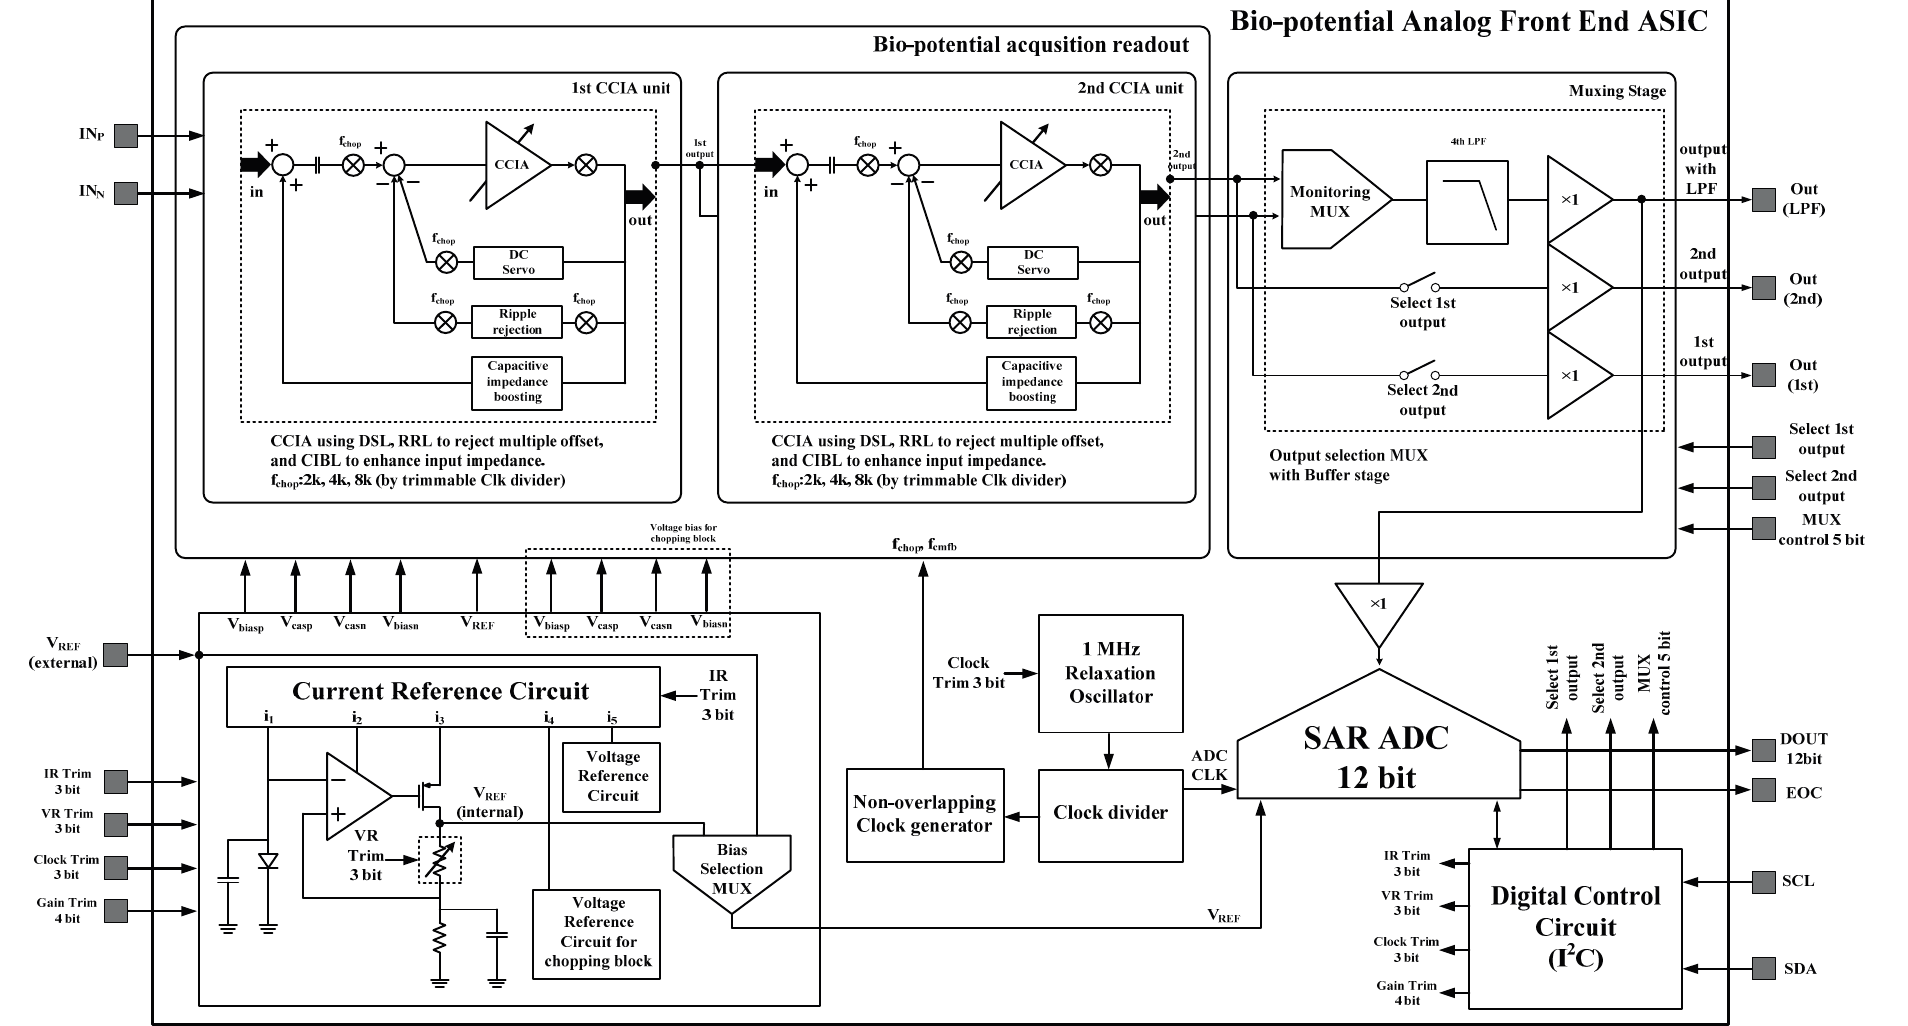
Figure 2. Architecture of a simplified biopotential acquisition